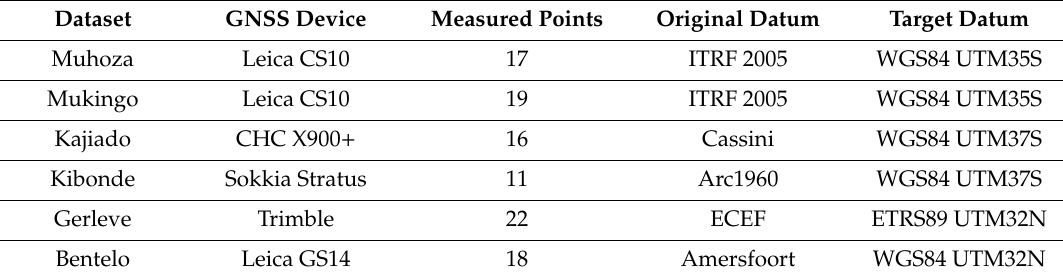
Table 2. Specifications of GCP measurements.